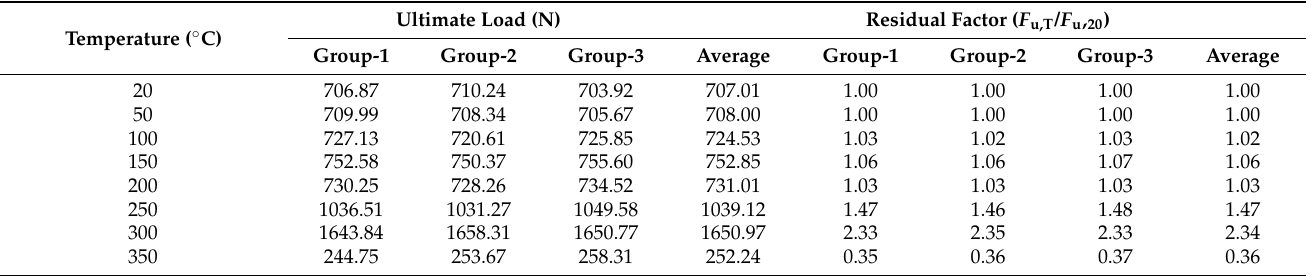
Table 2. Ultimate loads and residual factor sof FRP composites at elevated